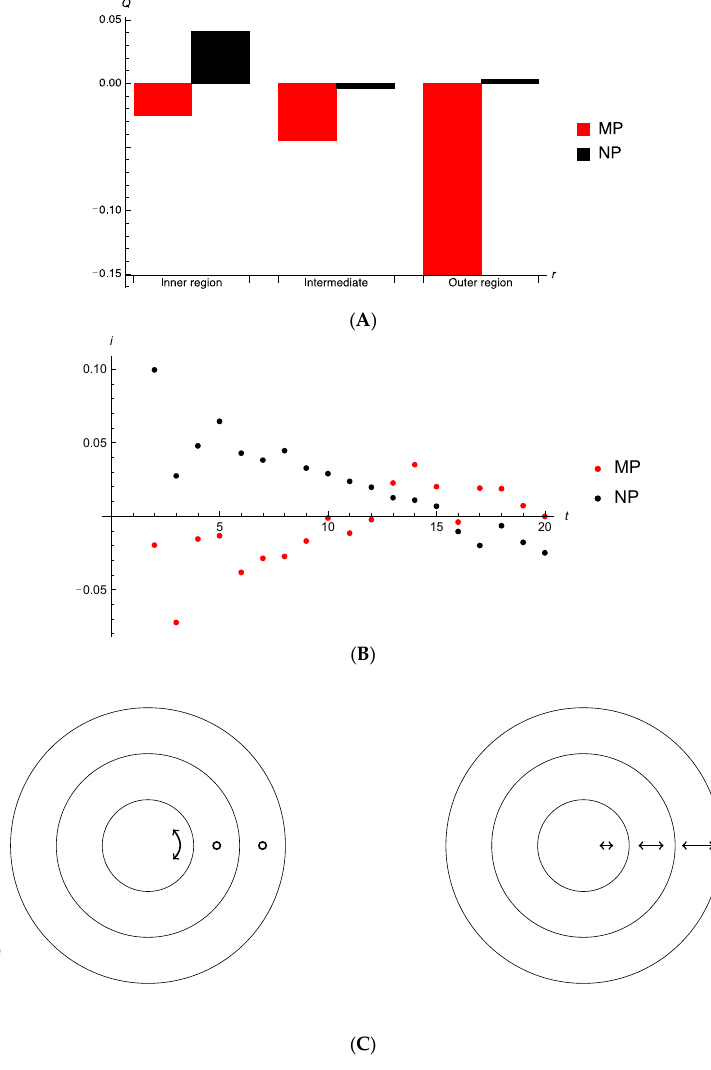
Figure 5. ( A ) Order measure Q as a function of radial distance for different segments of radius. No trend is discernable for the non-patterned cells (NP), but a clear radial motion, albeit rather small, for micropatterned cells (MP). In the micropatterned cells, autophagosome motion seems to be towards the periphery of the cell. ( B ) Average radial component of velocity per autophagosome punctum, as measured over 2 to 20 time ‐ steps. For micropatterned cells, labelled particles initially move slightly towards the edge of the cell. For non ‐ patterned cells, labelled particles are moving towards the centre. ( C ) Motion is mainly directed along the double ‐ headed arrow line. A minimum of three independent experiments ( n = 3) were performed.